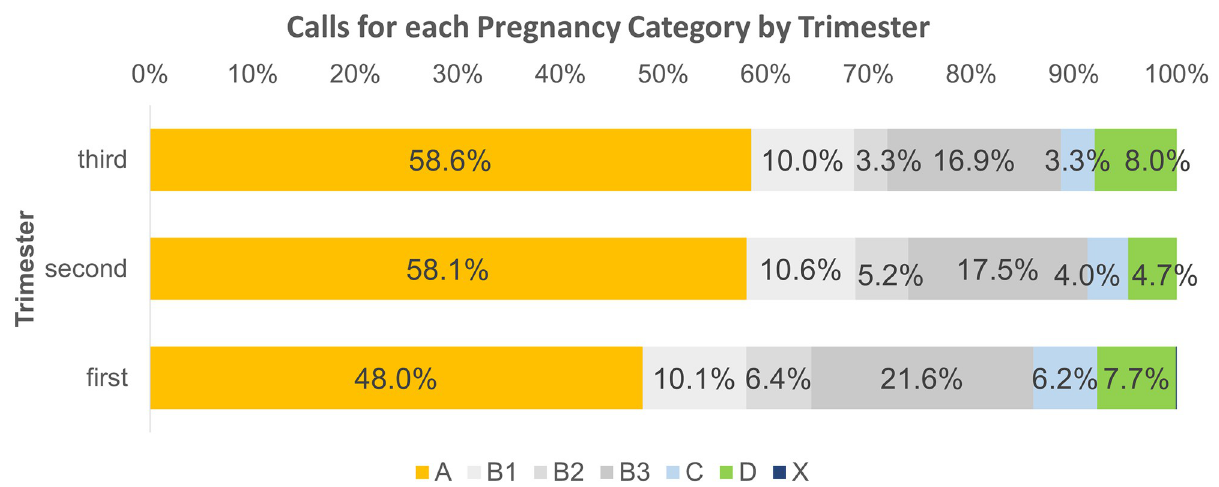
Fig 2. Pregnancy categories of all enquiries during pregnancy by patient trimester.